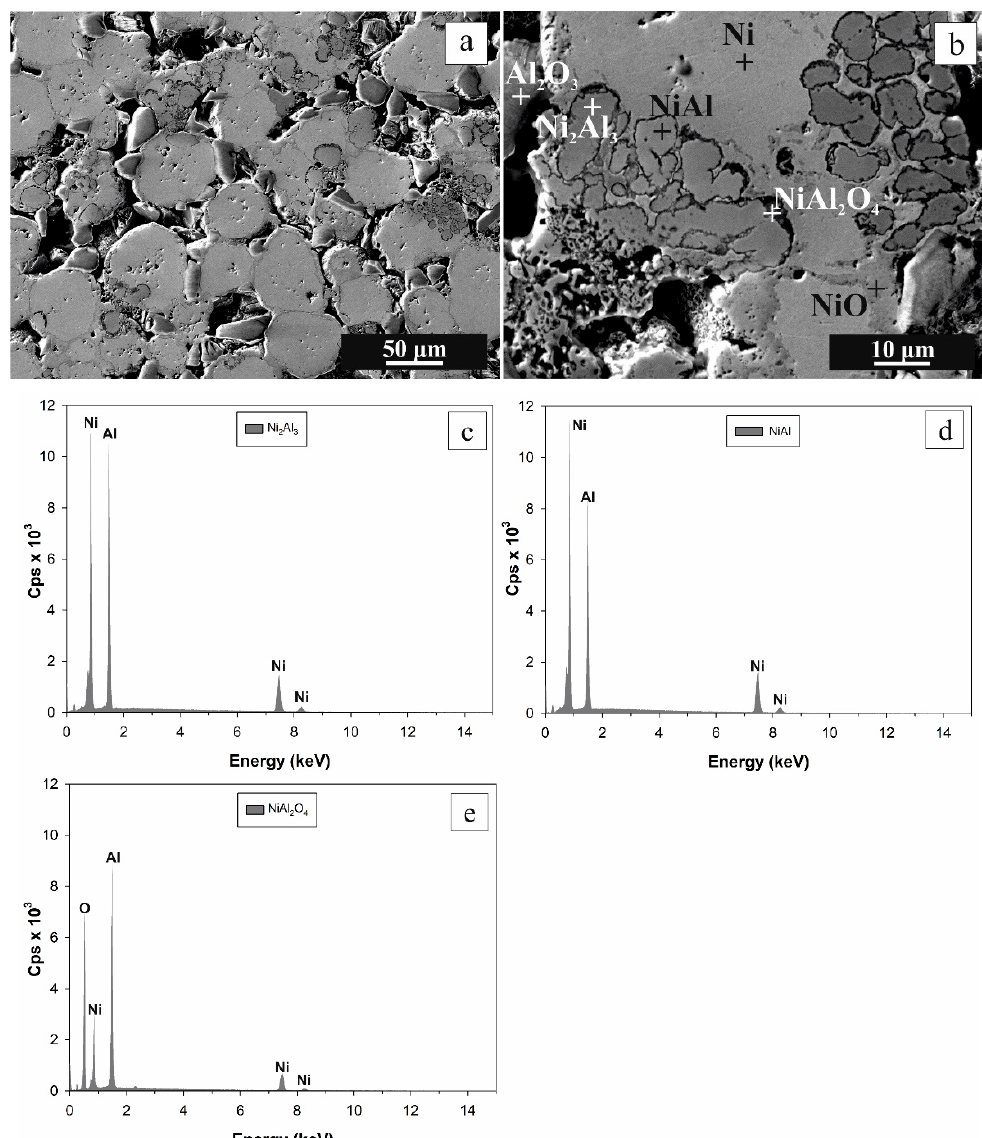
Figure 6. SEM images from the central region of the oxidized CIP green tablet at magnification 300× ( a ) and 1500× ( b ). Thermal oxidation was performed in an oven at the final temperature of 800 °C. The phases, determined by EDS, are denoted by the cross ( b ). EDS spectra were obtained by point analysis in Ni 2 Al 3 ( c ), NiAl ( d ), and NiAl 2 O 4 ( e ).